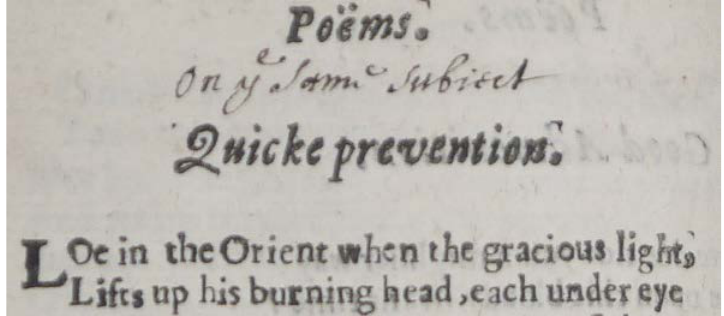
Fig. 3 – Folger STC 22344 Copy 2, sig.